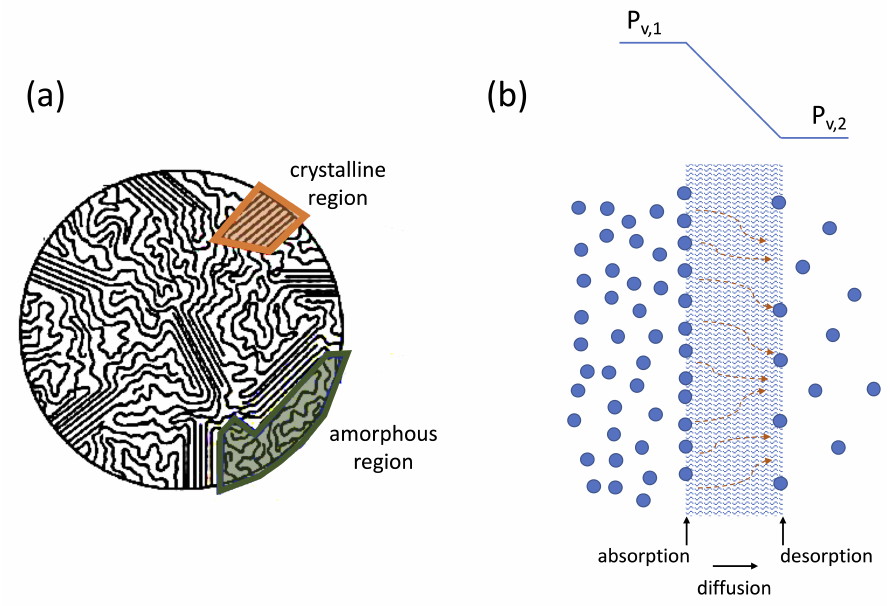
Figure 9. Sketch of a polymer morphology consisting of crystalline and amorphous regions ( a ) and schematic of the gas permeation process through a polymer separating two regions where a gas species has different partial pressures, P v ,1 > P v ,2 ( b